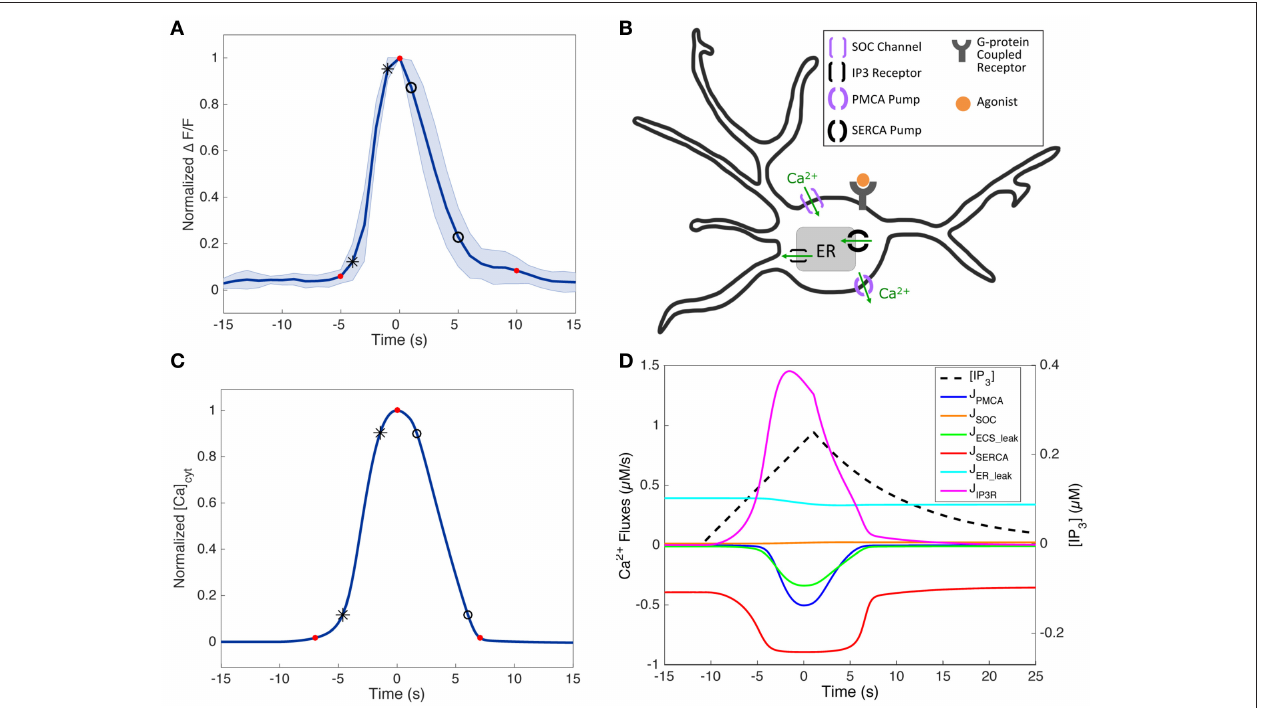
FIGURE 3 | Short-duration SP Ca 2 + traces in experiments and the model. (A) Normalized average short-duration ( < 25s) SP Ca 2 + traces of the soma ( N = 8, mean ± standard deviation, stimulus durations 16–250ms). The response amplitude and latency were ignored by normalizing the amplitudes and aligning the response peaks. (B) Simplified schematic of an astrocyte and its major Ca 2 + components incorporated in the model (except for GPCR dynamics, which is replaced with IP 3 as the input). Additionally, leak terms between the cytosol and extracellular space (J ECS_add ) and between the cytosol and the ER (J ER_leak ) are included in the model. Arrows show the direction of Ca 2 + flux. The model has only one compartment, tuned to represent data from different astrocyte subcompartments (see section Variability between Astrocyte Subcompartments: Model). (C) Normalized SP response in the model, fitted to match the experimental trace in (A) . IP 3 parameters ( A , d rise , r rise , d dec ): 0.25, 12, 0.002, 40. The experimental and model Ca 2 + rise times (calculated between the black star markers), decay times (between the black circles), and durations (between the first and last red circles) are as follows: 2.90, 3.90, and 14.7s (for experiments), and 3.19, 4.38, and 14.05s (for the model). (D) Simulated IP 3 dynamics and Ca 2 + fluxes corresponding to (C)